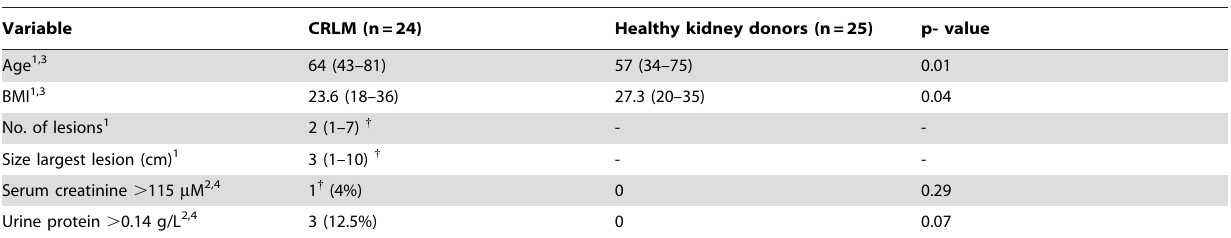
{ 1 missing CRLM, Colorectal Liver Metastasis; BMI, Body Mass Index. 1 Data are presented as median with the range between brackets. 2 Data are presented as numbers with the percentage between brackets .